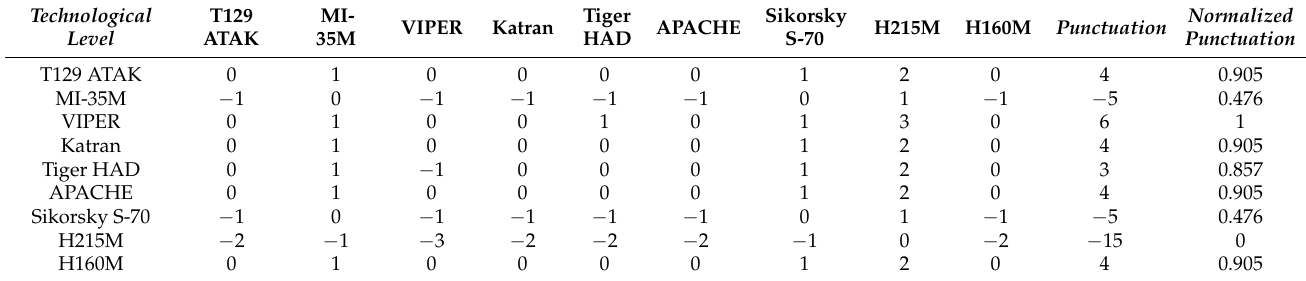
Table 5. Evaluation of alternatives under qualitative criterion Technological level .